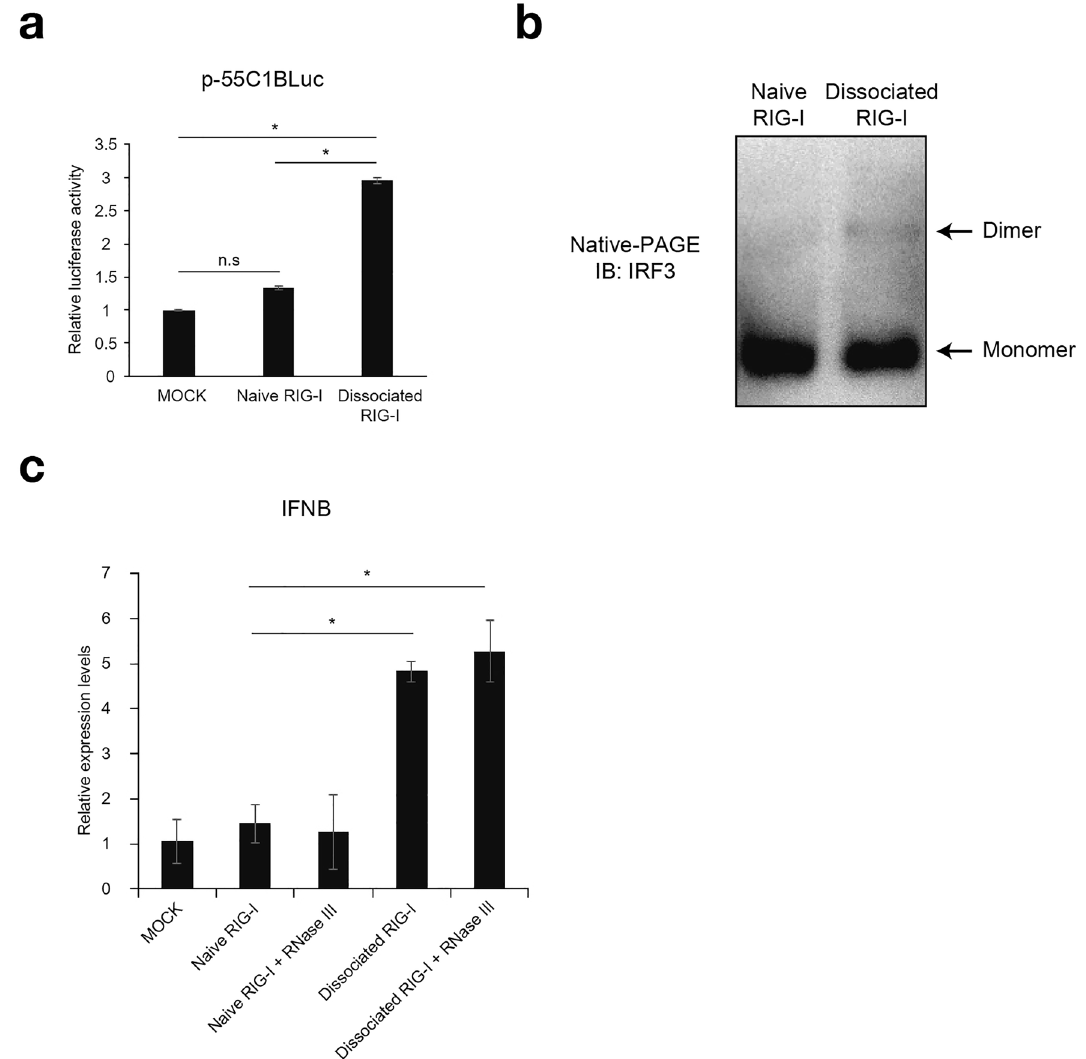
Figure 5. Biological activity of dissociated RIG-I in cells. ( a ) 293 T cells were transfected with p-55C1BLuc, reporter gene containing repetitive IRF3 binding sites, and pRL-TK as an internal control vector. Twenty-four hours after transfection, cells were transfected with 1 µg of naïve or dissociated RIG-I protein, isolated from MDA5 KO 293 T cells, by protein transfection reagent for 2 h (METHODS). After 4 h cultivation with fresh medium, cell extracts were prepared for dual-luciferase assay. Relative firefly luciferase activity normalized by Renilla luciferase activity is shown. Luciferase activity data are the average of 2 independent experiments. Error bars represent standard deviation (n = 2). * P < 0.05, unpaired Student’s t -test. n.s, not significant. ( b ) The cell extracts were analyzed by native PAGE for IRF-3 dimer formation. The positions of monomers and dimers are indicated. The uncropped original blot is shown in Supplementary Fig. S10. ( c ) Naïve or dissociated RIG-I protein, isolated from MDA5 KO 293 T cells, was transfected into HeLa by after 30 min incubation with RNase III. The expression level of IFNB was analyzed by qPCR. Error bars represent standard deviation (n = 2). * P < 0.05, unpaired Student’s